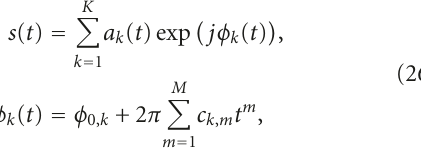
algorithm based on the traditional chirplet